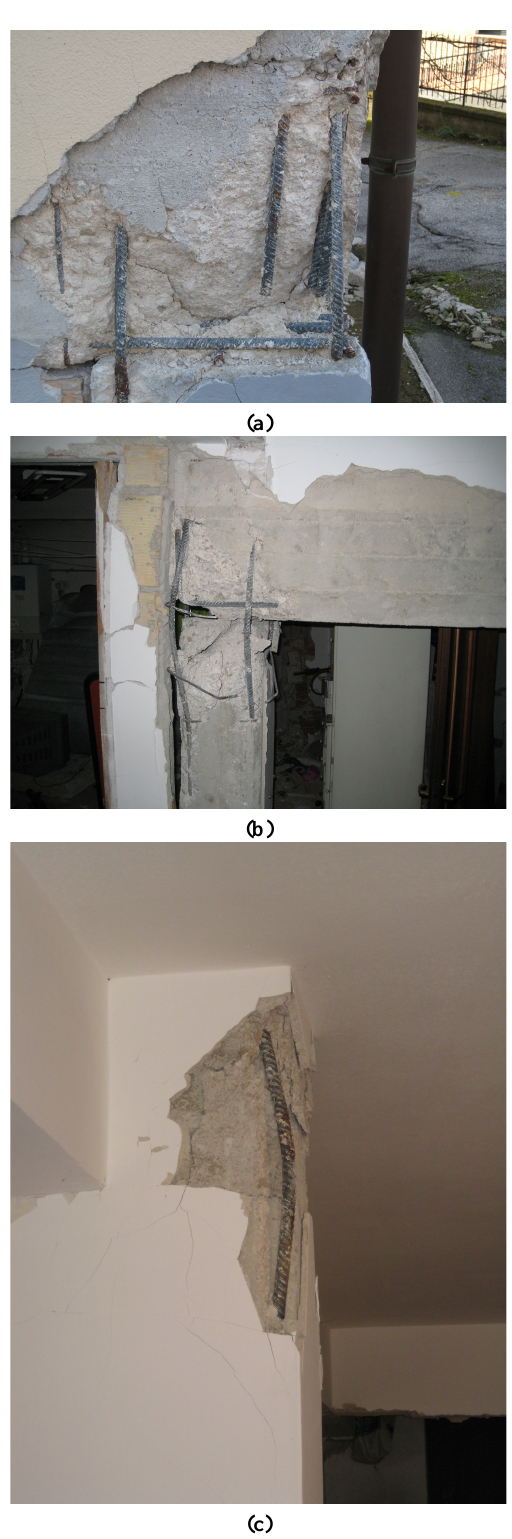
Fig. 1. Reinforcement details of an RC building designed taking into account the Italian seismic code